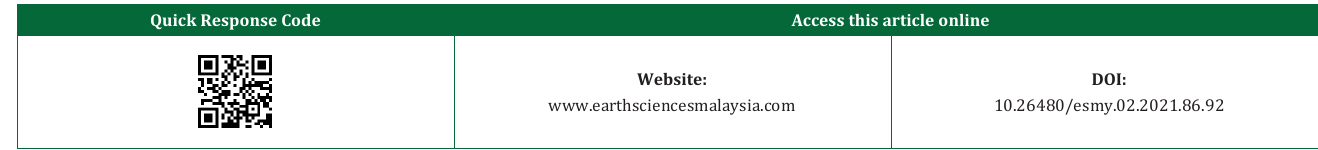
Figure 1: location map of study